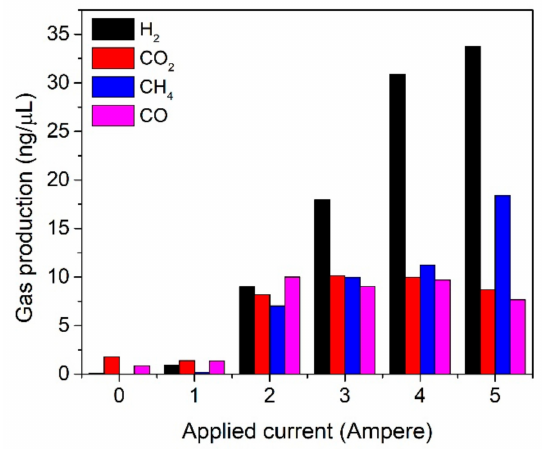
Figure 4. Syngas production improvement in the increasing of an applied electromagnetic current. Pyrolysis time and temperature were controlled at 60 min and 210 ◦ C, respectively